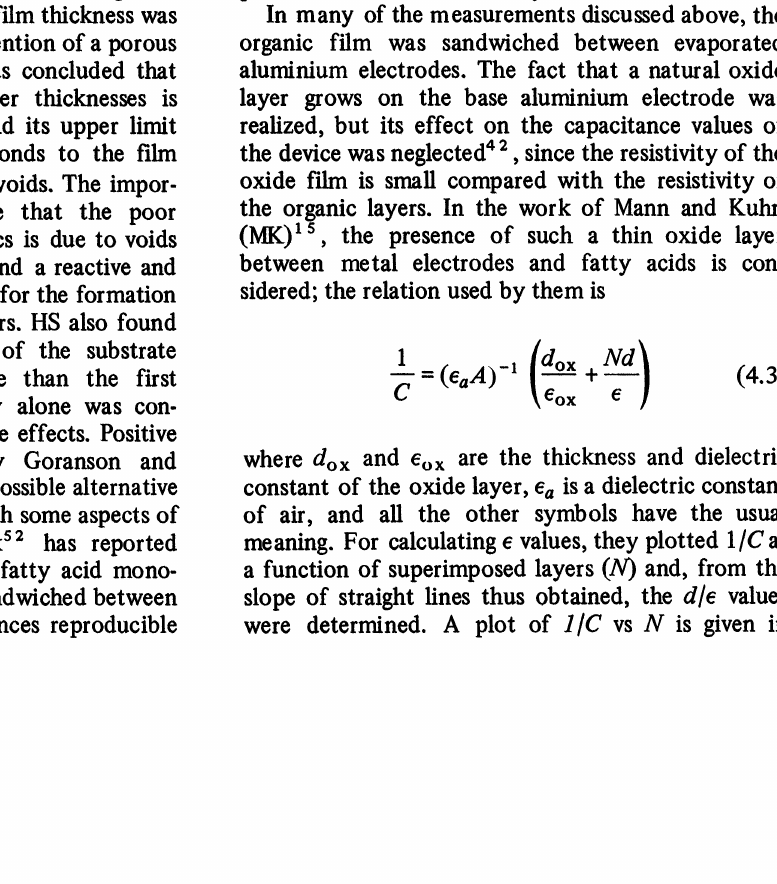
FIGURE 4 Capacity C vs. frequency f (upper curve) and capacity x dissipation factor (CXD) vs. frequency f flower curve). [After Handy and Scala4